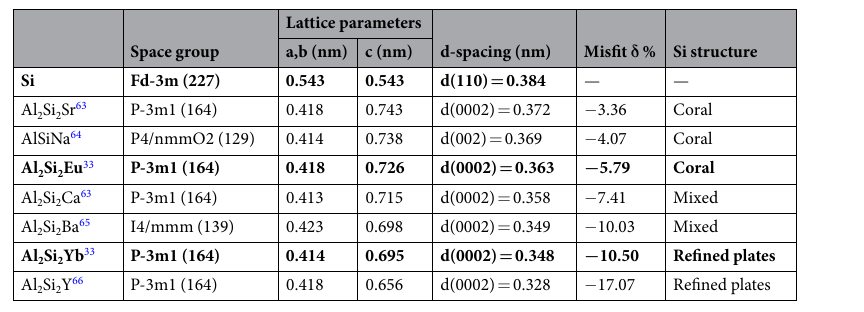
Table 2. Crystal structure and misfit of ternary compounds related to